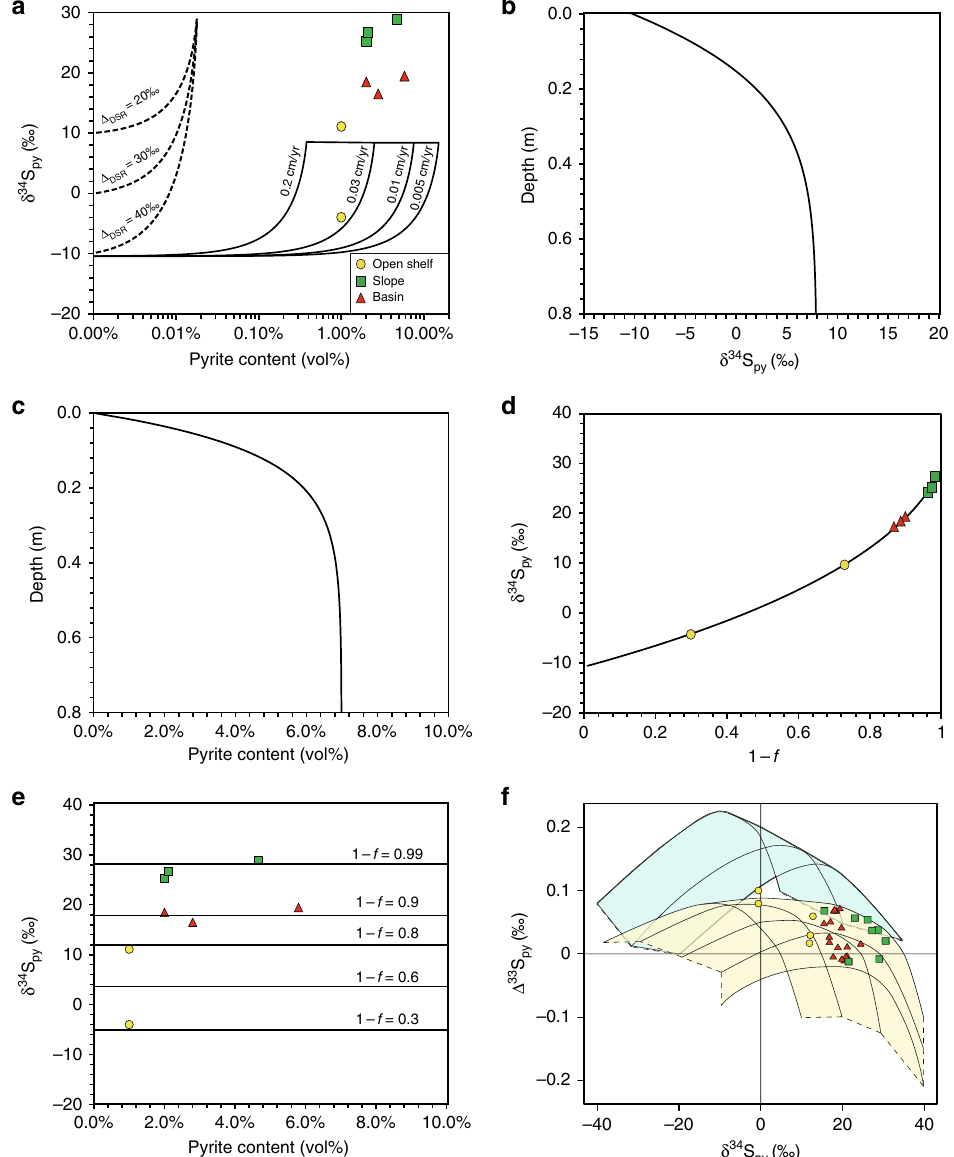
Fig. 3 Modeling results. a The Rayleigh distillation model (dashed lines, with different sulfur isotope fractionations or Δ DSR ) showing the relationship between δ 34 S py and pyrite content with DSR occurring within sediment porewater under a closed system. The 1D-DAR model result (solid lines, with different sedimentation rates) showing the relationship between δ 34 S py and pyrite content when DSR occurs in sediment porewater with sulfate supply by diffusion from the overlying seawater (an open system). b and c The maximum values of δ 34 S py and pyrite content are ~ + 8 ‰ and 6.99 vol% within sediments. The default parameters for D s , s , R , and [SO 4 ] 0 are 3.61 × 10 − 6 cm 2 s − 1 , 0.01 cm year − 1 , 1 year − 1 , and 3 mM L − 1 , respectively. d The Rayleigh distillation model quantifying the δ 34 S of H 2 S with DSR occurring in seawater. Assuming δ 34 S sw is 30 ‰ , sulfur isotope fractionation for DSR is 40 ‰ , variable δ 34 S values of the Nantuo pyrite concretions indicates the different degree of DSR (1 − f , f is the fraction of sulfate remaining). e The 1D-DR model result (black lines) showing DSR in water column followed by pyrite formation in sediment porewater fueled by H 2 S diffusion from sul fi dic seawater. This process can explain high δ 34 S py and high pyrite content in the basin and slope sections, indicating high degree of sulfate reduction in water column. f δ 34 S py − Δ 33 S py cross-plot 37 . Individual contour lines represent modeled sulfur isotopic compositions of pyrite formed from a sulfate pool with an initial sulfur isotope at the right end of the lines. Modeled values in the blue fi eld require a bacterial sulfur disproportionation (BSD), whereas the yellow fi eld indicate pyrite formed by DSR only. Measured data from pyrite in the top Nantuo Formation fall in the yellow fi eld, suggesting that the pyrite was precipitated in an anoxic environment where DSR but not BSD